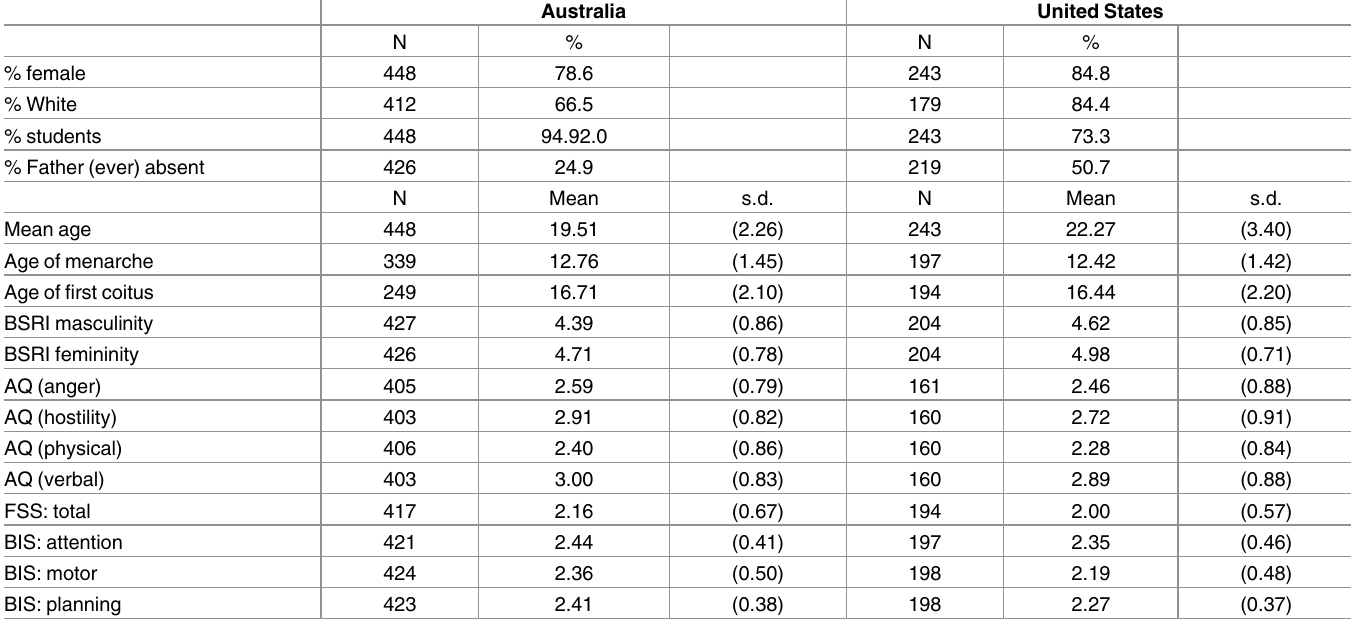
Table 1. Descriptive statistics for samplecharacteristics and raw outcome measurescores. (BSRI = Bem Sex Role Inventory; AQ = Aggression Ques- tionnaire;FSS = Fear Survey Schedule; BIS = Barratt Impulsivity Scale.) Ns represent the number of participantsproviding data for each